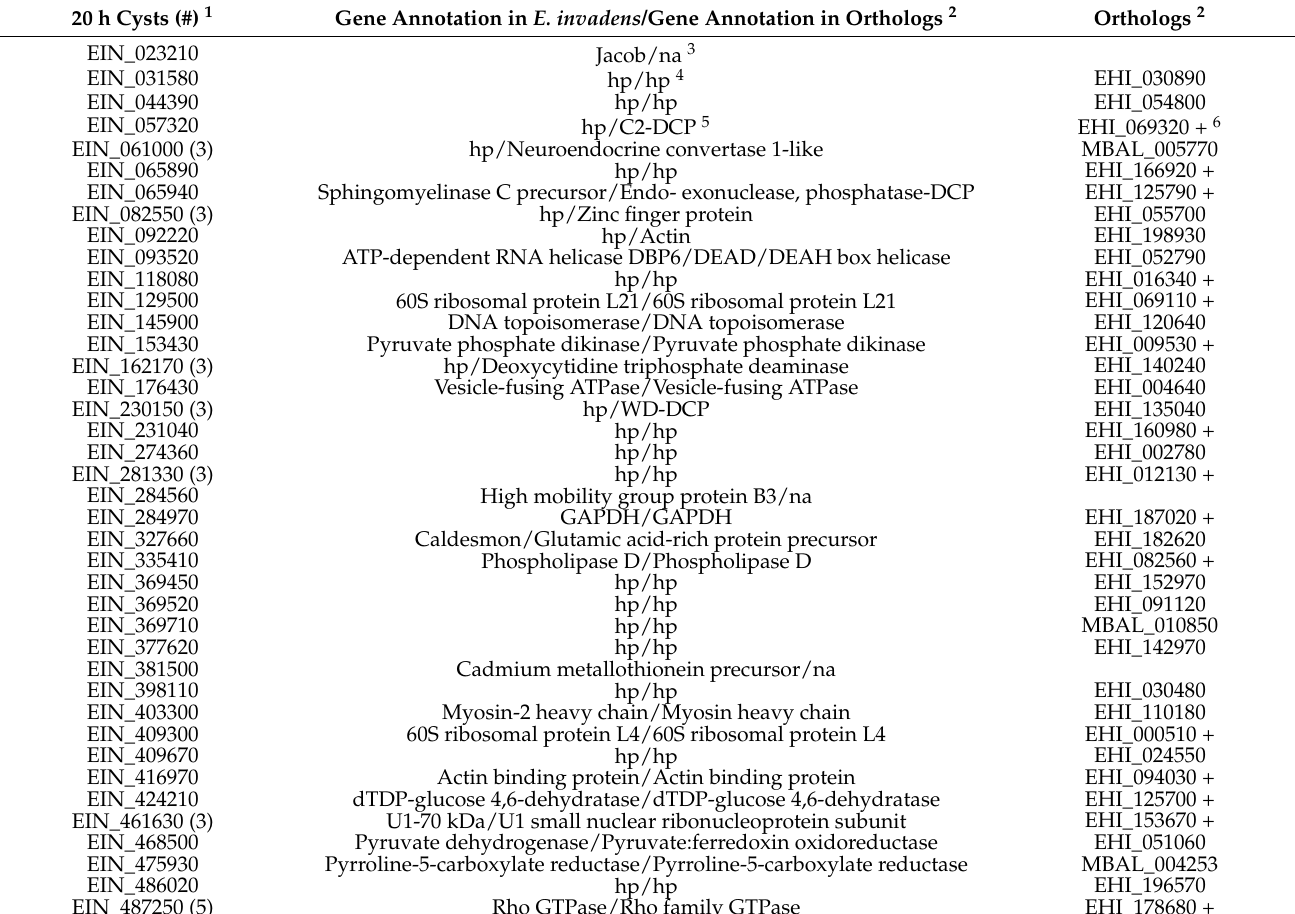
Table 3. Entamoeba invadens encystment-specific